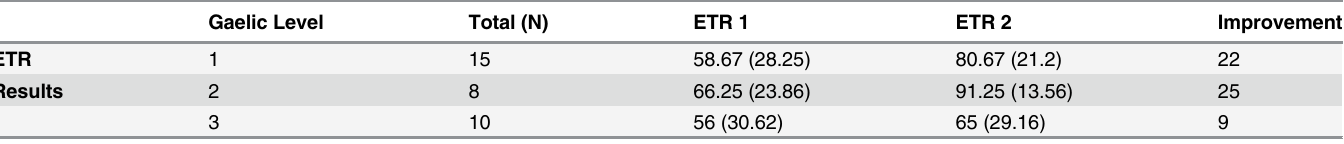
Table 2. Elevator Task with Reversal performance for the three levels of Gaelic